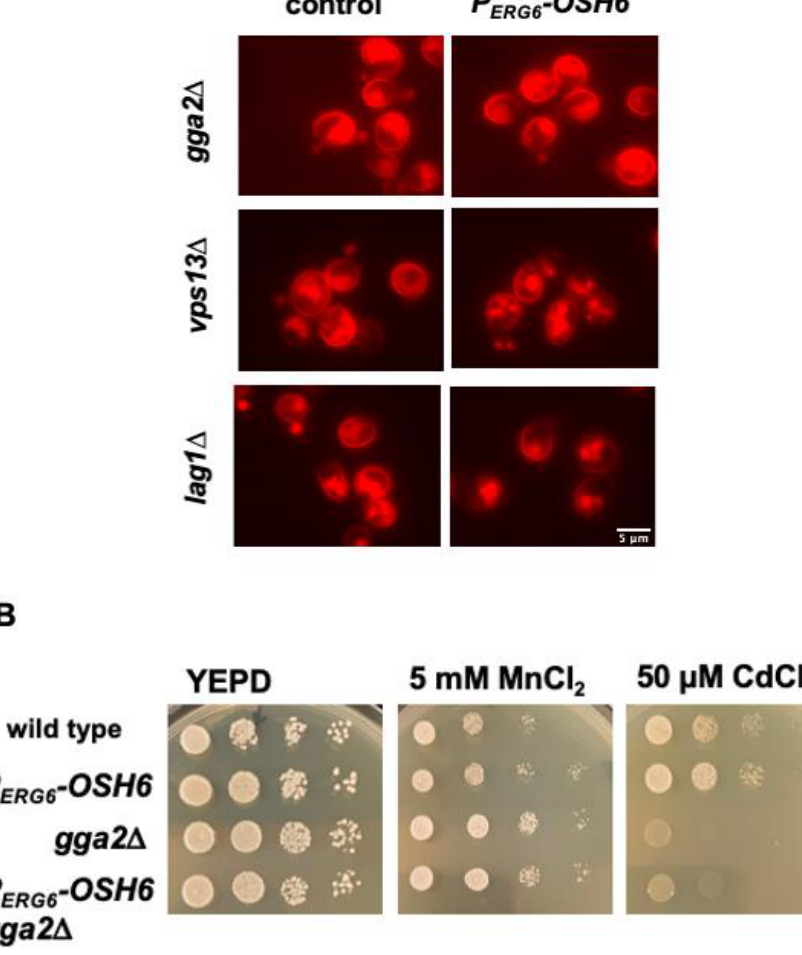
( Fig. 2D ). The localization data of Osh6 from Orin’s lab show that Osh6 can work on TGN. A chromosomal version of GFP-tagged Osh6 with its endogenous promoter localiz- es to the PM and intracellular organelles in small buds [35]. During yeast cell division, organelles such as ER, late Golgi stage of budding [20, 36, 37]. Since ER hosts Sac1 and de- grades PI4P, we conclude that the enriched PI4P in small buds of P ERG6 - OSH6 ( Fig. 2C ) is a sign of Osh6 working on late Golgi elements. In line with this conclusion, in P ERG6 - OSH6 cells a portion of Pma1 was rerouted to vacuoles ( Fig. 3 ), phenocopying mutants missing Drs2 or Osh4, two pro- teins working on the TGN [12].